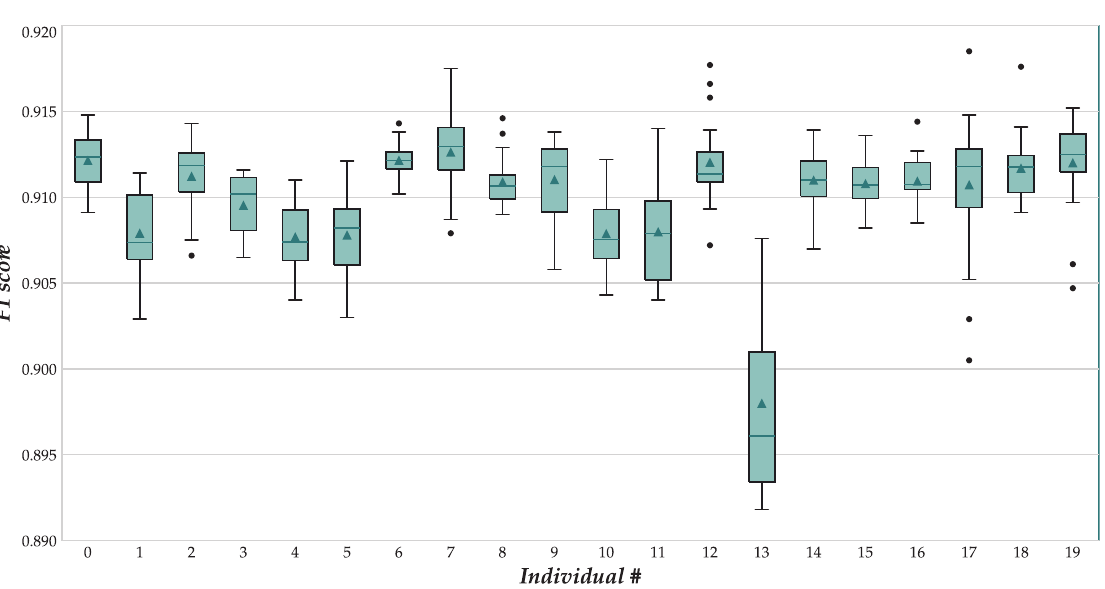
Figure 5. Boxplot showing the distribution of F1 scores of the best 20 GE individuals after full training in OPPORTUNITY